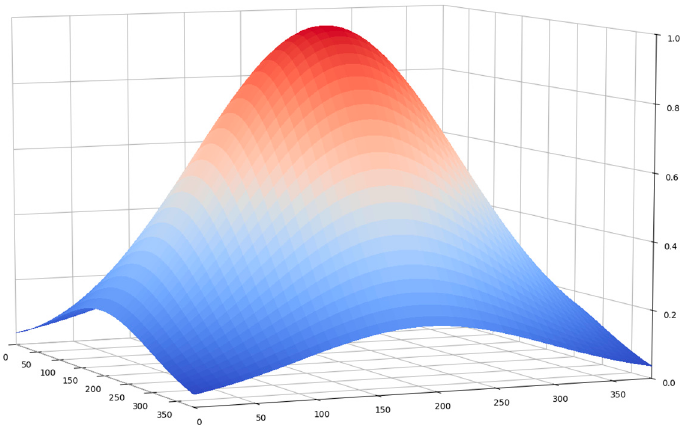
Figure 4. The Gaussian kernel used for weighting segmentation model predictions.